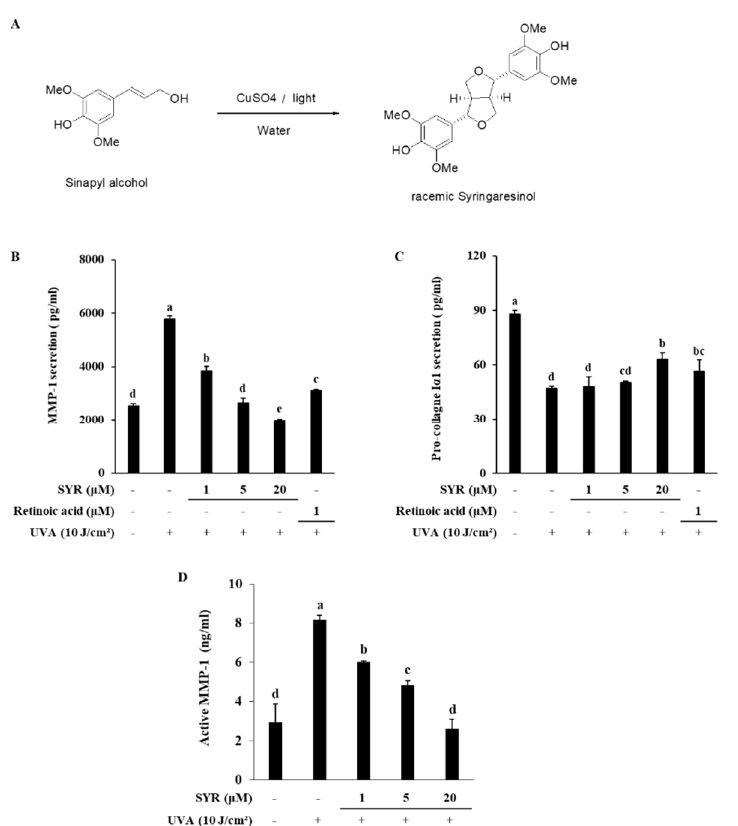
Figure 1. Synthesis of (±)-syringaresinol (SYR) ( A ) and its effect on UVA-induced release of MMP-1 and procollagen I α 1 in HaCaT keratinocytes. Cells were treated with given concentrations of SYR for 24 h after UVA irradiation (10 J/cm 2 ), and levels of MMP-1 ( B ) and procollagen I α 1 ( C ) release along with MMP-1 activation ( D ) were measured. Retinoic acid was used as a positive control. Values are means ± SD of three independent experiments run in triplicate. Different letters (a–e) indicate statistically significant difference at p < 0.05 level by Duncan’s multiple range test.